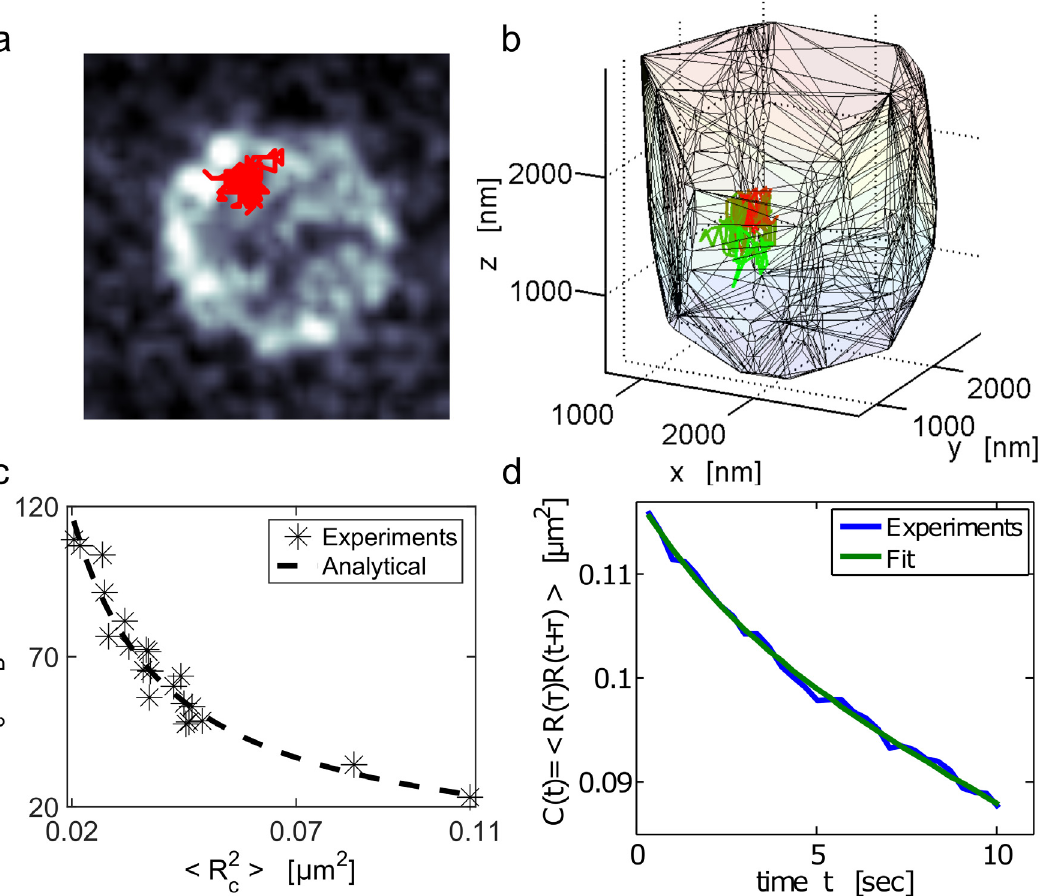
Fig 4. Single locus dynamics and mean applied force on the Yeast chromatin. ( a ) Trajectory of the chromatin MAT-locus located on chromosome III in the yeast SS. The locus trajectory (red) inside the nucleus is projected on the XY plane. The nuclear membrane (gray scale) was stained with the nup49-mCherry fusion protein. The time resolution is Δ t = 0.33 seconds during an acquisition time of approximately 100 seconds. ( b ) Three-dimensional trajectories: the color codes for time propagation. Initially ( t = 0) the trajectory is red and gradually becomes green ( t = 100sec). The convex hull is the nuclear envelope reconstruction. ( c ) Scatter plot of the effective spring coefficient k c and the variance ( R 2 c ) of the locus trajectory estimated in two-dimensions, extracted for 21 cells. The constant k c is estimated using formula Eq (24), fi tted to a power law, k c ¼ a , with a = 3.03 ± 1.05 k B T and b = 0.94 ± 0.1. ( d ) Auto- h R 2 c i b correlation function computed using formula Eq (28) for the trajectory shown in a. The fi t uses the sum of two exponentials: C ð t Þ ¼ a 1 e (cid:2) t = t 1 þ a 2 e (cid:2) t = t 2 , with τ 1 = 45.7 ± 0.005 s and τ 2 = 2.4 ± 0.35 s, a 1 = 109 ± 5 × 10 − 3 μ m 2 , a 2 = 8.38 ± 4.94 × 10 − 3 μ m 2 .